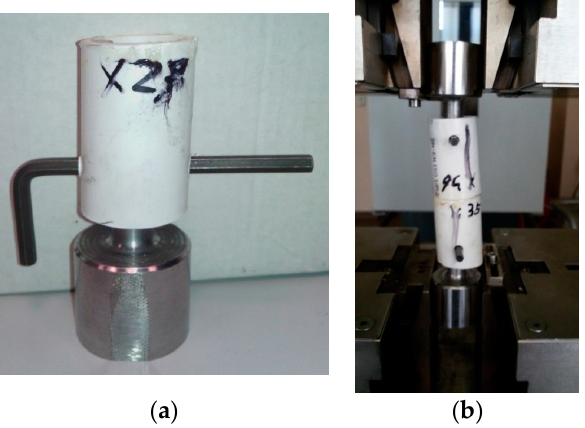
Figure 4. View of: ( a ) sample holder, for example, mounted on damaged sample; ( b ) adhesive joints sample with holder is mounted in jaws of testing machine.